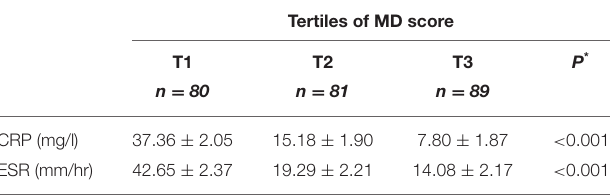
TABLE 3 | Inflammatory biomarkers across tertiles of Mediterranean diet. Tertiles of MD score